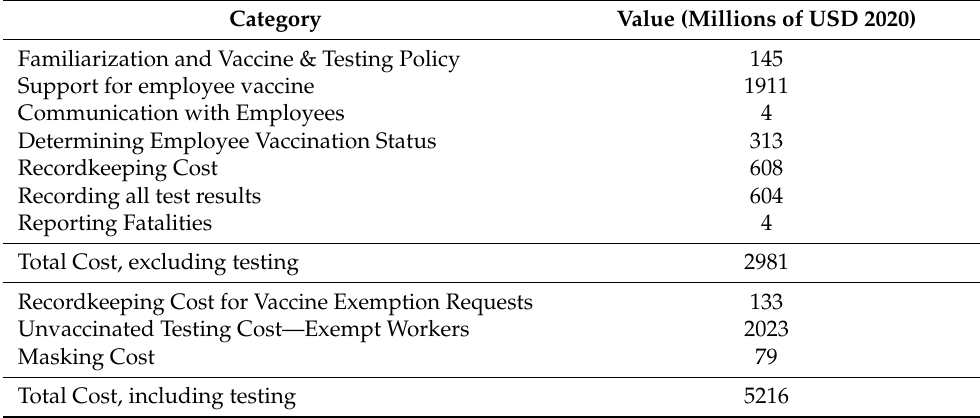
Table 3. OSHA’s COVID-19 Vaccination and Testing ETS